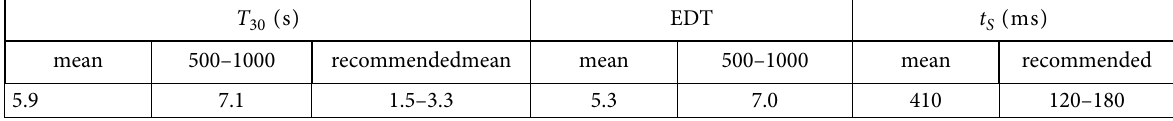
Table 1. Values of acoustic parameters T 30 , EDT and t S obtained from in situ measurements along with recommended values T 30 (s)